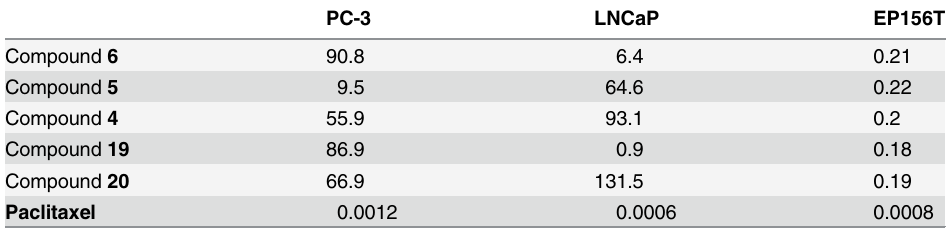
Table 1. Estimated EC 50 values for cell